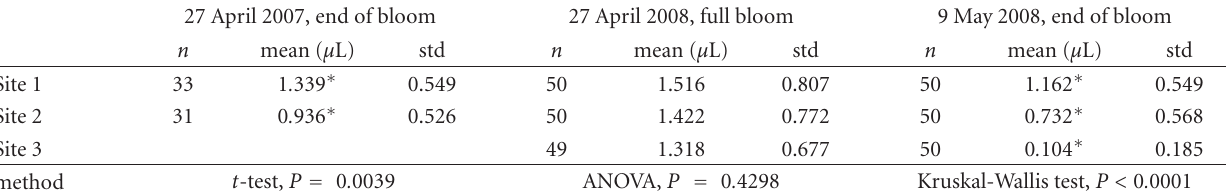
Table 5: The e ff ect of habitat on nectar volume.